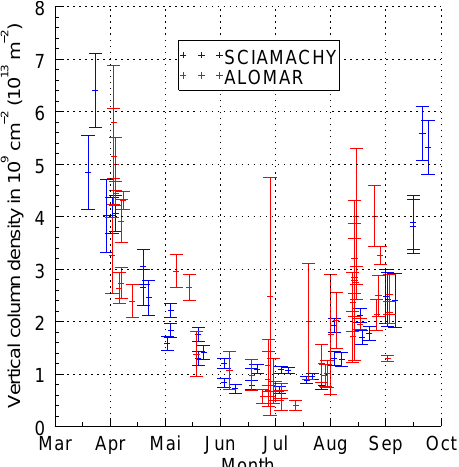
) difference of the Na VCDs retrieved from the D 1 and D 2 lines. D 1 + D 2